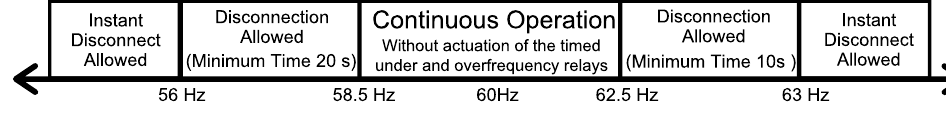
Figure A1. Nonrated frequency regime for wind and solar generating units [38].